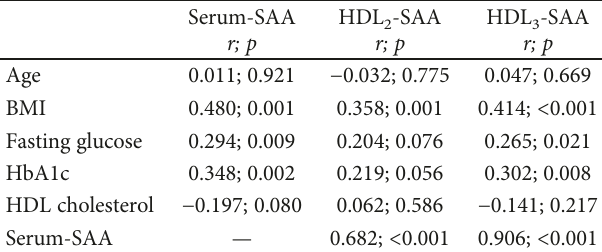
Table 3: Correlations between SAA and subject